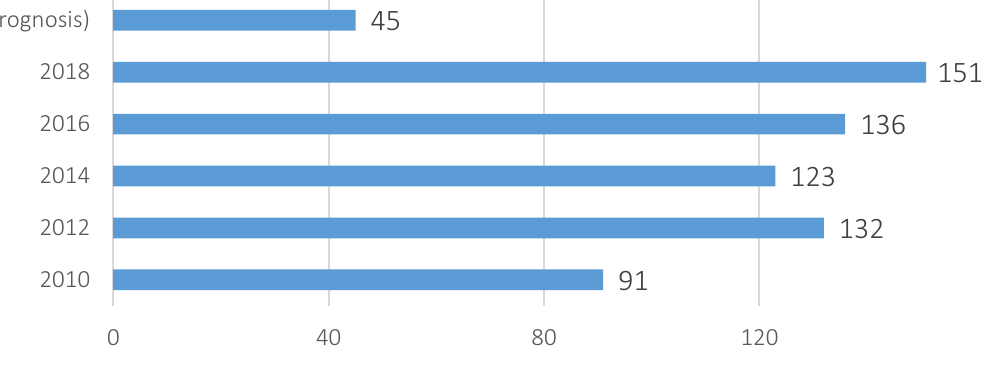
Figure 1. Revenues to the city budget from the tourism industry, UAH million